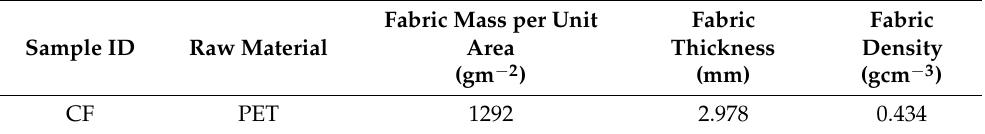
Table 1. The constructional parameters of the Novbelt compound